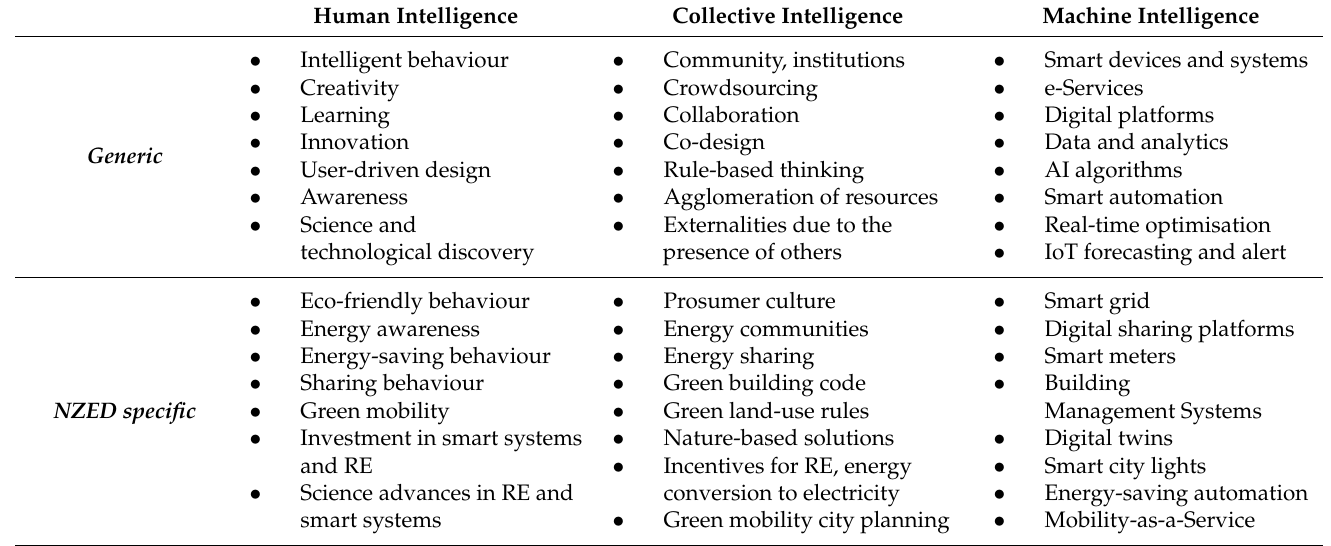
Table 1. Connected intelligence as an integration of three types of